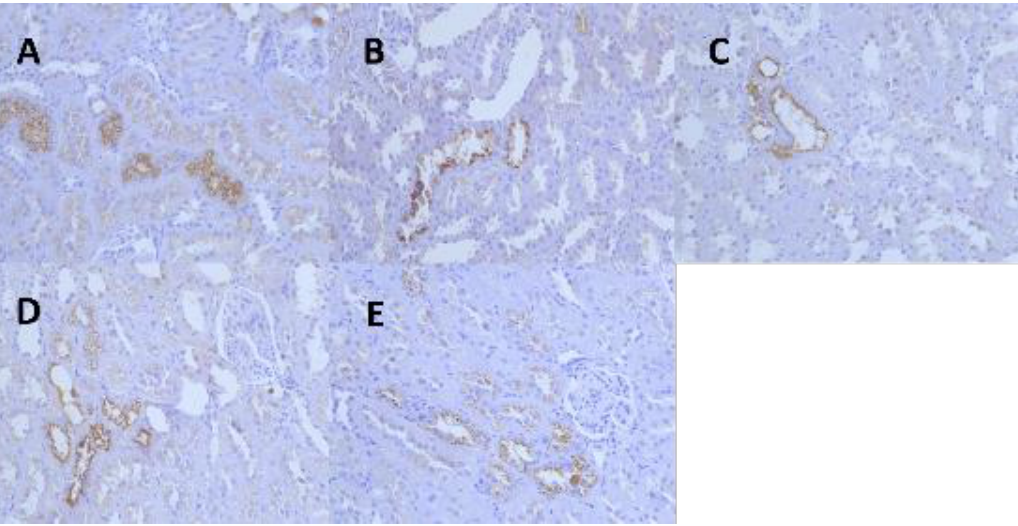
Figure 5. Representative images of renal α -2u globulin in each dose group and control group at 13 weeks. ( A ) (IHC 40 × 10, control group), ( B ) (IHC 40 × 10, 1.36 mg/kg group), ( C ) (IHC 40 × 10, 5.44 mg/kg group), ( D ) (IHC 40 × 10, 21.76 mg/kg group), ( E ) (IHC 40 × 10, 174.08 mg/kg group). Table 5. Histopathological findings of SD rats orally administered AQ for 90 days. Table 7. Results of immunohistochemical grading of renal α -2u globulin in male rats at the end of the AQ Organ and Tissue Find-